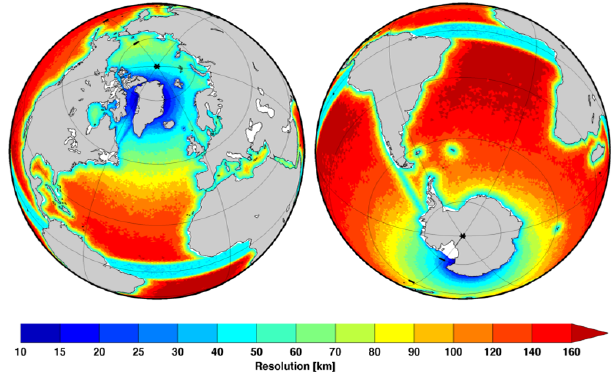
Figure 1. Horizontal resolution of FESOM’s unstructured